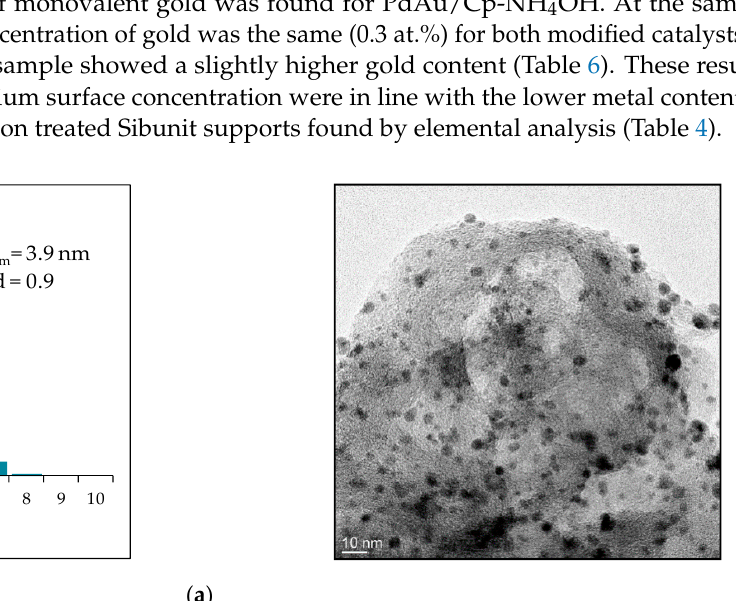
Figure 3. XRD patterns for catalysts PdAu/Cp ( a ), PdAu/Cp-HNO 3 ( b ) and PdAu/Cp-NH 4 OH ( c ) and their corresponding supports.